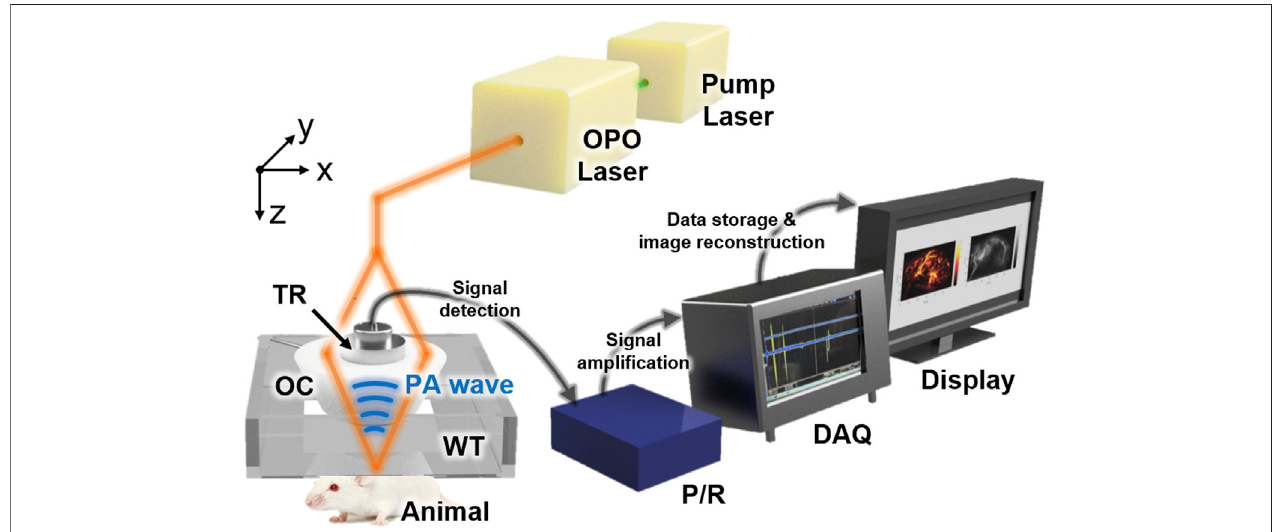
FIGURE1| Schematiccon fi gurationofthedual-modalPAandUSmacroscopysystemforwhole-bodyimagingofmice invivo .PA,photoacoustic;US,ultrasound; OPO, optical parametric oscillator; OC, optical condenser; TR, transducer; WT, water tank; P/R, pulser/receiver; DAQ, data acquisition